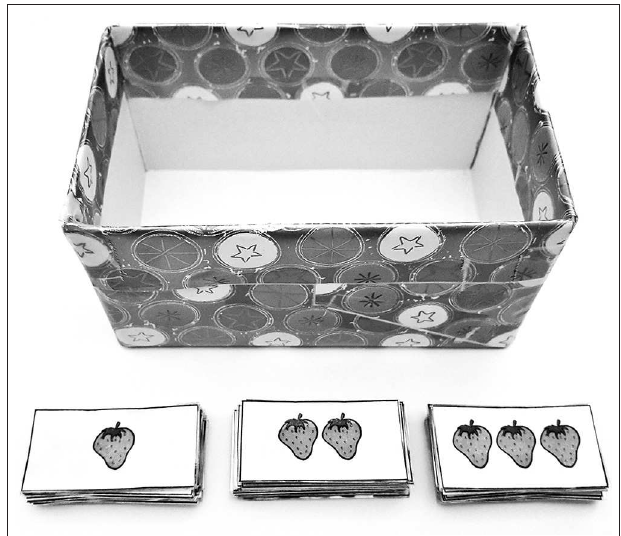
FIGURE 8 | Materials used in the ternary judgment task. Clearly false targets were meant to elicit the minimal reward of one strawberry. Clearly true targets were meant to elicit the maximal reward of three strawberries. Based on the results reported in Katsos and Bishop (2011), the intermediate reward of two strawberries was meant to correspond to underinformative